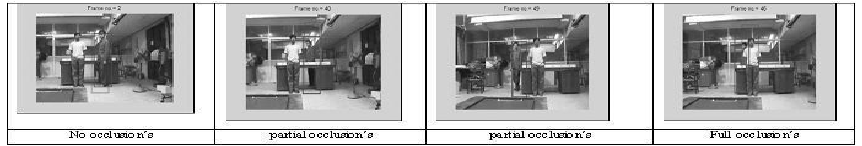
Figure 6. Video under